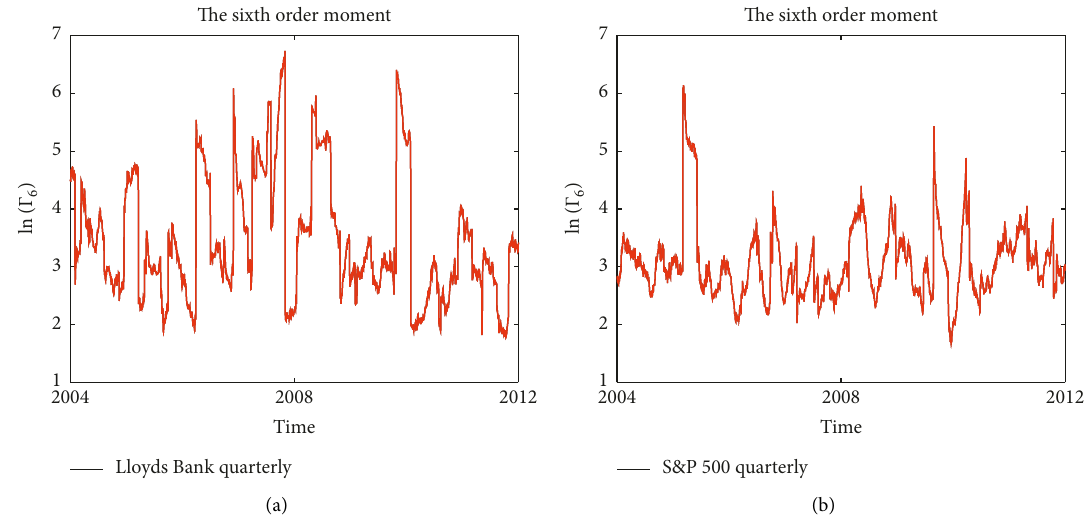
Figure 15: The time evolution of the sixth-order standardised moment for Lloyds Bank, panel (a) and the S&P 500 index, panel (b), when we truncate the long 18-year time series into quarterly time windows (around 63